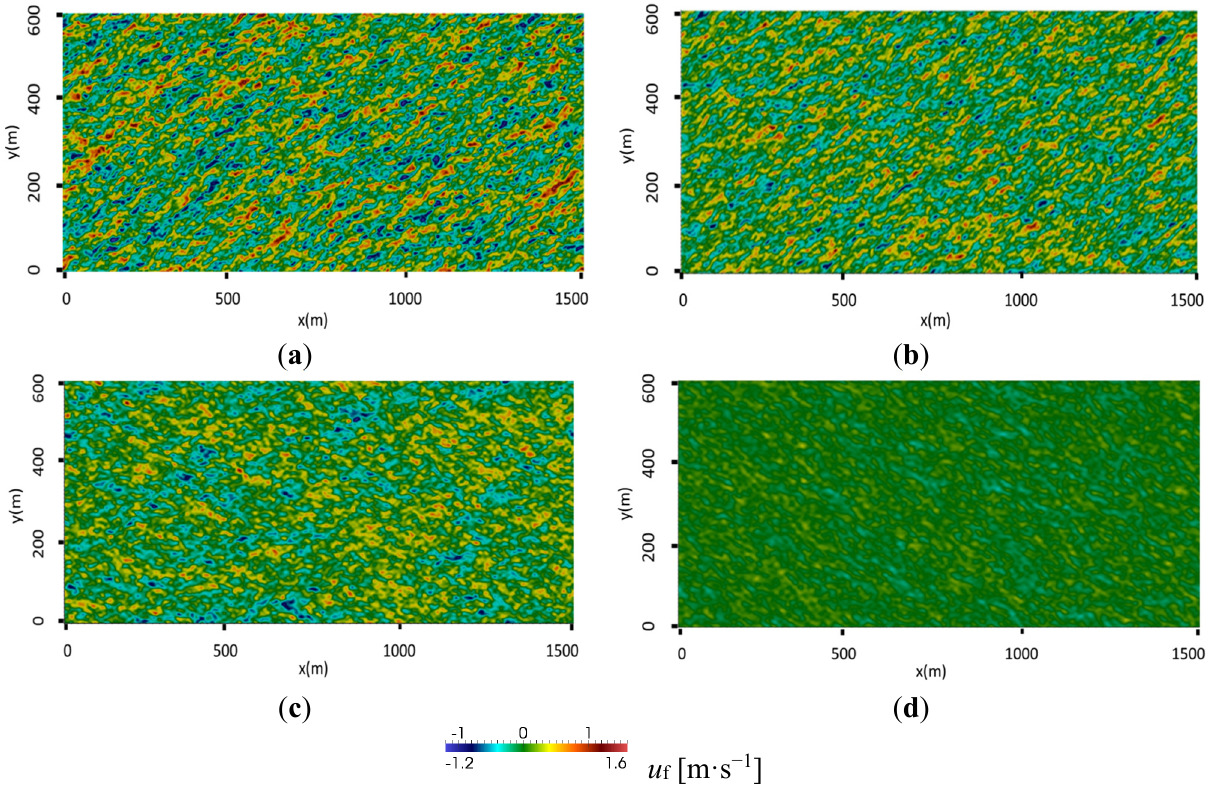
Figure 3. Streamwise fluctuating velocity (u f ) ( a ) low-stable at z = 30 m; ( b ) moderate-stability at z = 30 m; ( c ) low-stability at z = 90 m; ( d ) moderate-stability at z = 90 m (hub-height) ABL